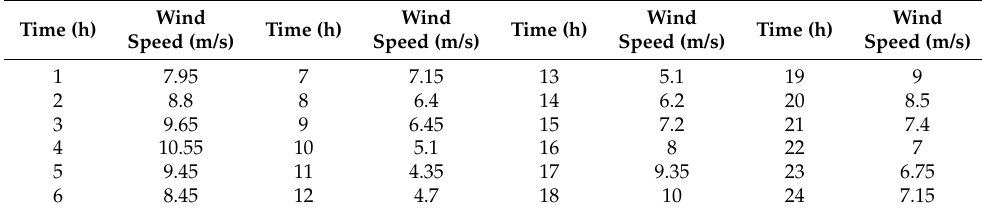
Table A6. Wind speed in 24